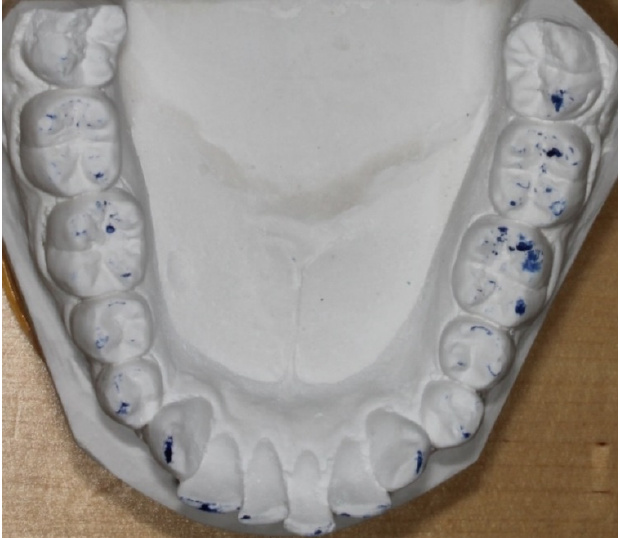
Figure 2. Lower jaw in the study cast examination.